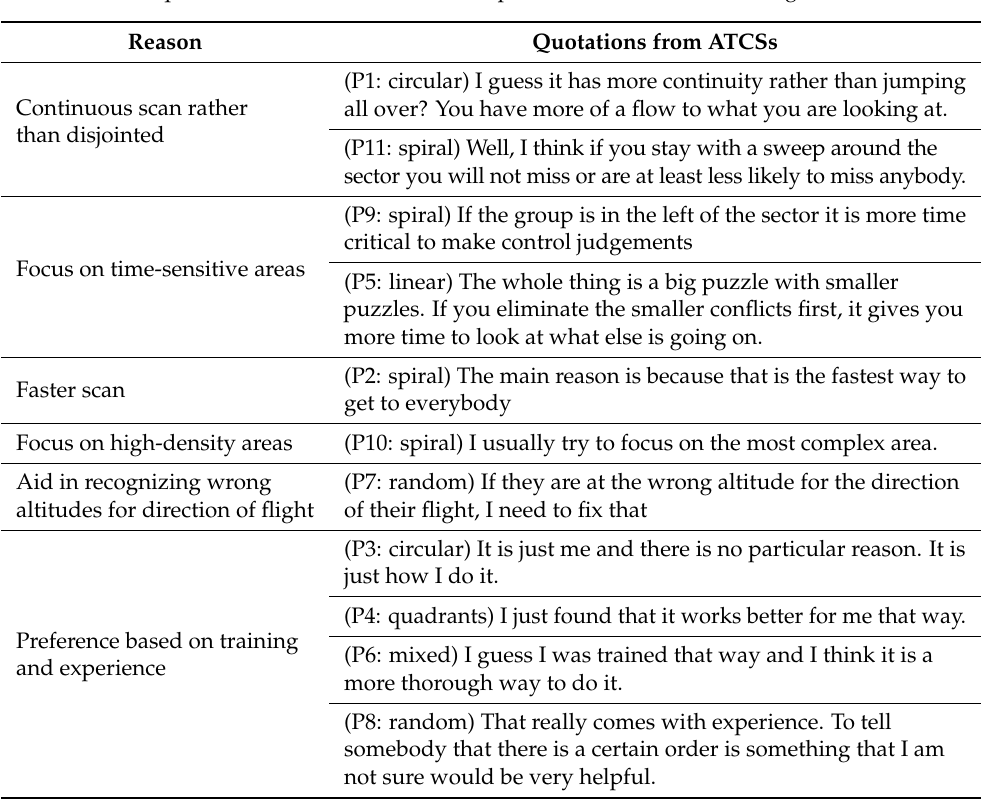
Table 4. ATCSs quotations on reason behind their preferred visual search strategies. Quotations from ATCSs